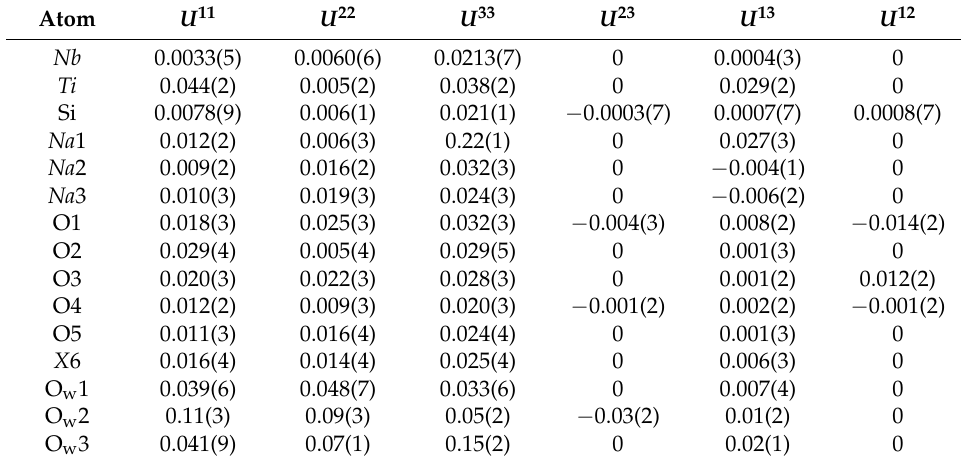
Table 4. Anisotropic displacement atom parameters for shkatulkalite (Å 2 ).